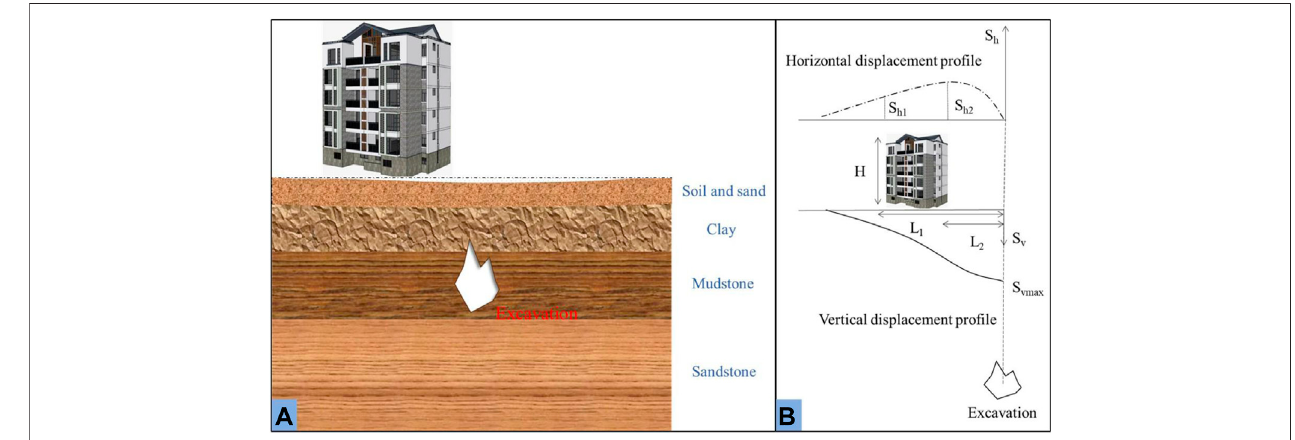
FIGURE 1 | Horizontal view of building damage mechanism.